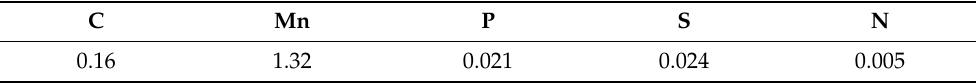
Table 2. Contents of alloying elements (wt%) in S235JR steel investigated in the present work. C Mn P S N 0.16 1.32 0.021 0.024